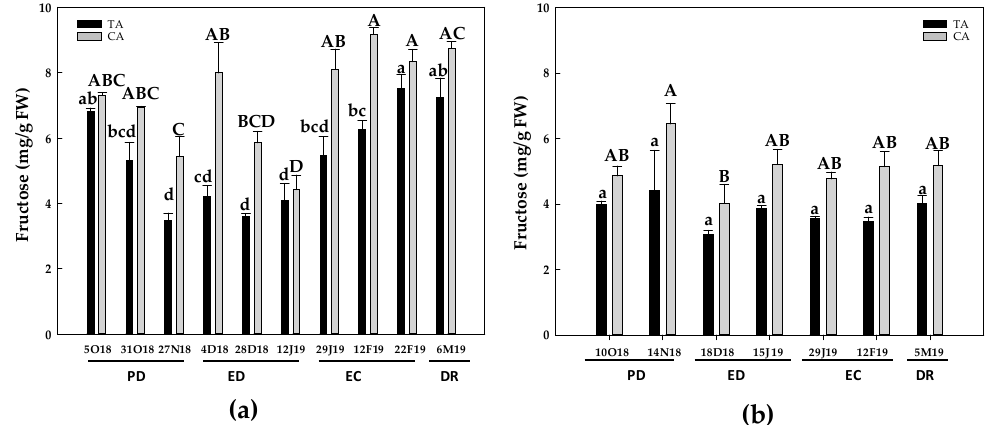
Figure 5. Evolution of fructose contents in flower buds of peach ‘GEM020’ cultivated in two different geographical areas during the dormancy cycle on two seasons. ( a ): season 1 (2017–2018); ( b ): season 2 (2018–2019). Data represent the mean ± SE, n = 3. Different letters (lowercase and uppercase for the samples of the temperate (TA) and the cold area (CA), respectively) indicate significant differences according to Tukey’s multiple test ( p ≤ 0.05). PD: paradormancy; ED: endodormancy; EC: ecodormancy; DR: dormancy release. FW: fresh weight. The chill units accumulated at the different times and locations are shown in Supplemental file 1.